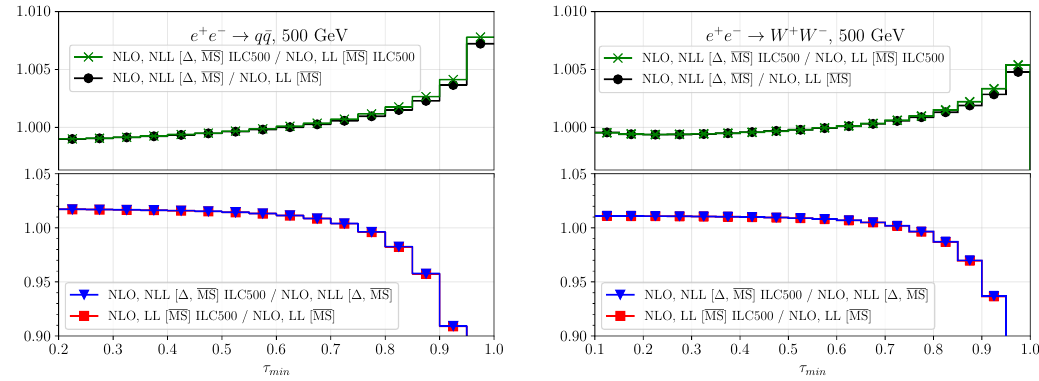
Figure 10 . Results of simulations that include beamstrahlung effects at ILC500, and their com- parisons with those obtained without beamstrahlung. See the text for details. Left panel: q ¯ q production; right panel: W + W −